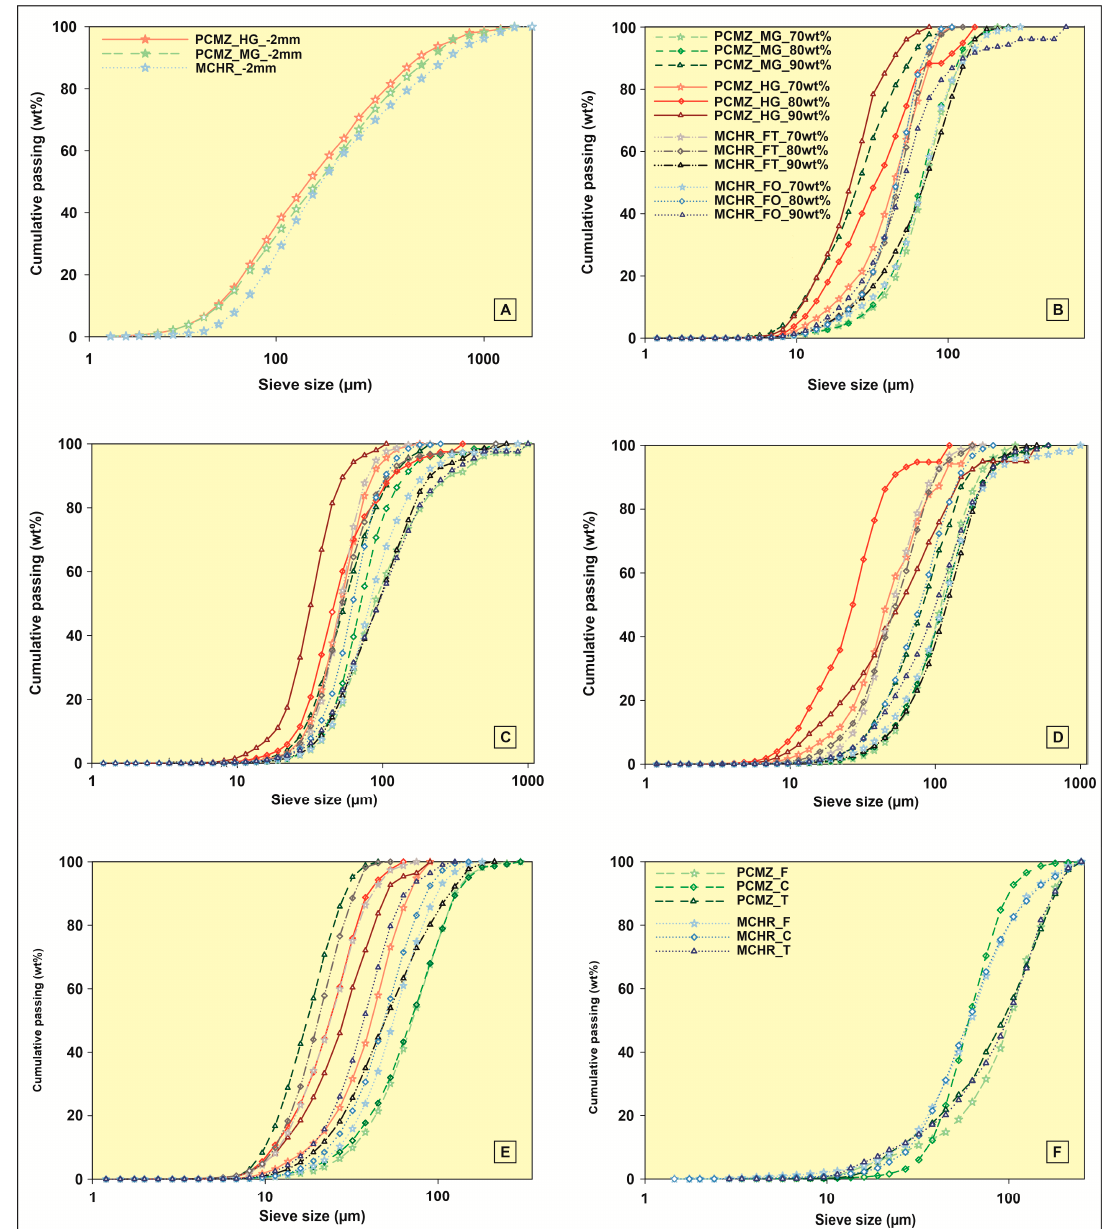
Figure 7. Chromite grain size distributions. ( A ) − 2 mm crush samples. ( B ) Feed samples. ( C ) Concentrate samples. ( D ) Middlings samples. ( E ) Tailings samples. ( F ) PCMZ and MCHR samples from the concentrator plant.